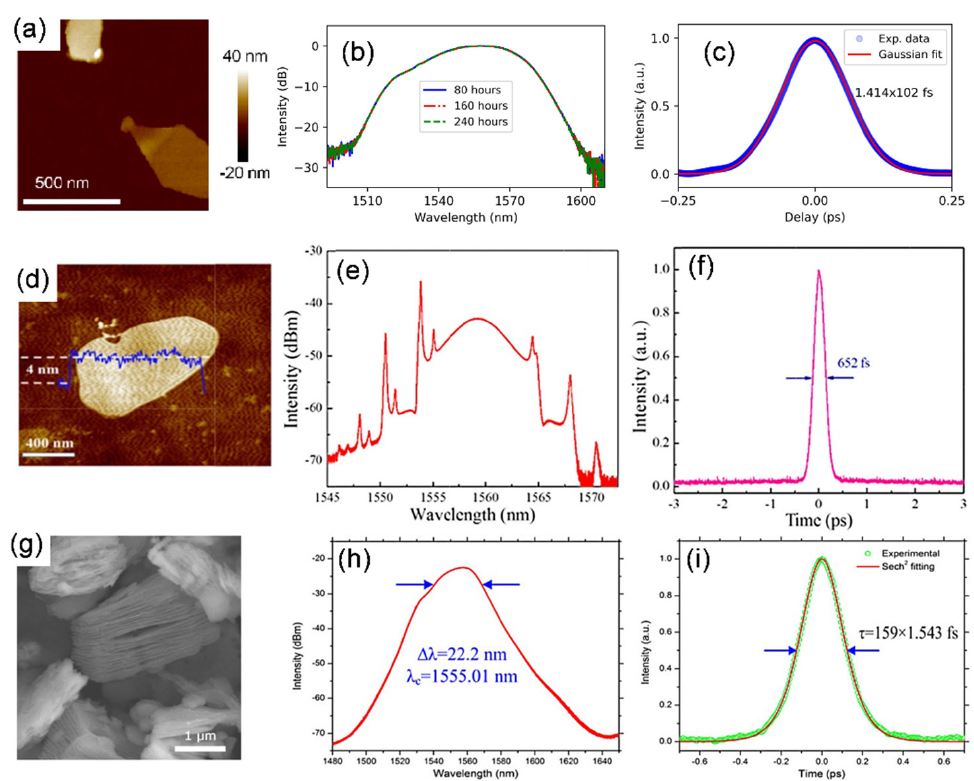
Figure 8. Mode-locked ultrafast fiber laser in the NIR region with various 2D SAs such as BP ( a – c ), Bismuthine ( d – f ), and Ti 3 C 2 T x MXene ( g – i ). ( a ) AFM micrograph of selected exfoliated BP fakes; ( b ) Optical spectrum with a bandwidth of 40 nm acquired after 80 h (blue curve), 160 h (red dot line), and 240 h (green dot line), respectively; ( c ) Autocorrelation trace with a Gaussian fit. ( a – c ) Reproduced with permission. Copyright 2018, The Optical Society of America [135]. ( d ) AFM image of few-layer bismuthine. ( e ) mode-locked soliton pulse spectrum with 3 dB bandwidth of 4.64 nm, and ( f ) autocorrelation trace of mode-locked ultrafast laser showing the pulse width of 652 fs. ( d – f ) Reproduced with permission. Copyright 2018, Wiley-VCH [191]. ( g ) SEM image of Ti 3 C 2 T x , ( h ) mode-locked soliton pulse spectrum with 3 dB bandwidth of 22.2 nm, and ( i ) autocorrelation trace of mode-locked fiber laser showing the pulse width of 159 fs. ( g – i ) Reproduced with permission. Copyright 2017, Wiley-VCH